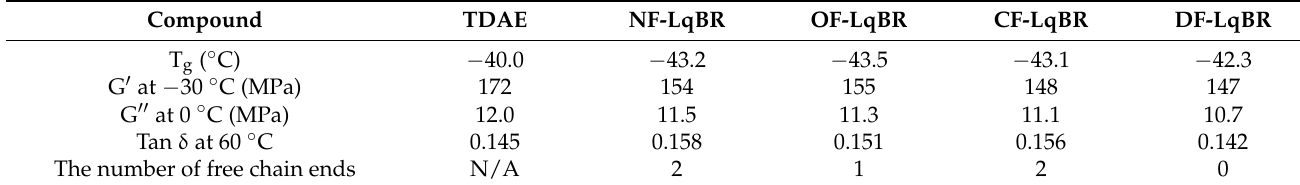
Table 10. Viscoelastic properties of the compounds according to the applied processing aids.